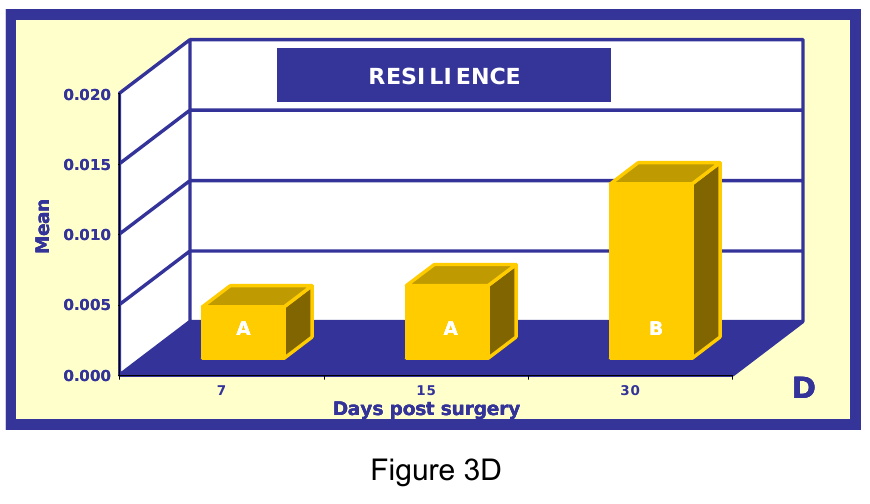
Figure 3: Mean variation of the four biomechanical properties evaluated in the traction tests of the deep digital flexor tendon segments in dog thoracic limb using snake venom derived fibrin glue at each observation period. Load [N] and deformation x 10 -5 [m] in the elasticity limit (A); load [N] and deformation x 10 -5 [m] in the maximum limit (B); rigidity [N/m] (C); and resilience [J] (D). Means with equal capital or small letters on the bars are not different by the Tukey test